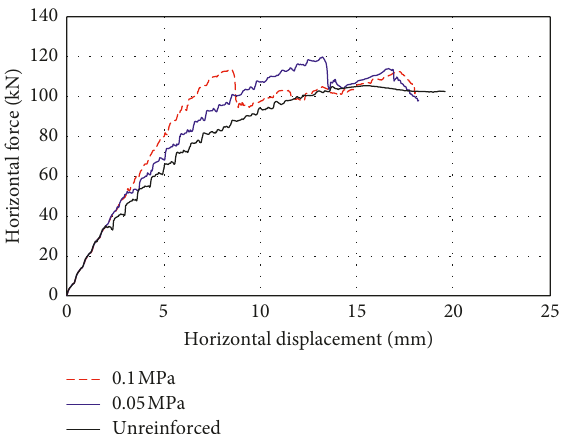
Figure 5: Relationship between horizontal force and horizontal displacements for the case of two-storey